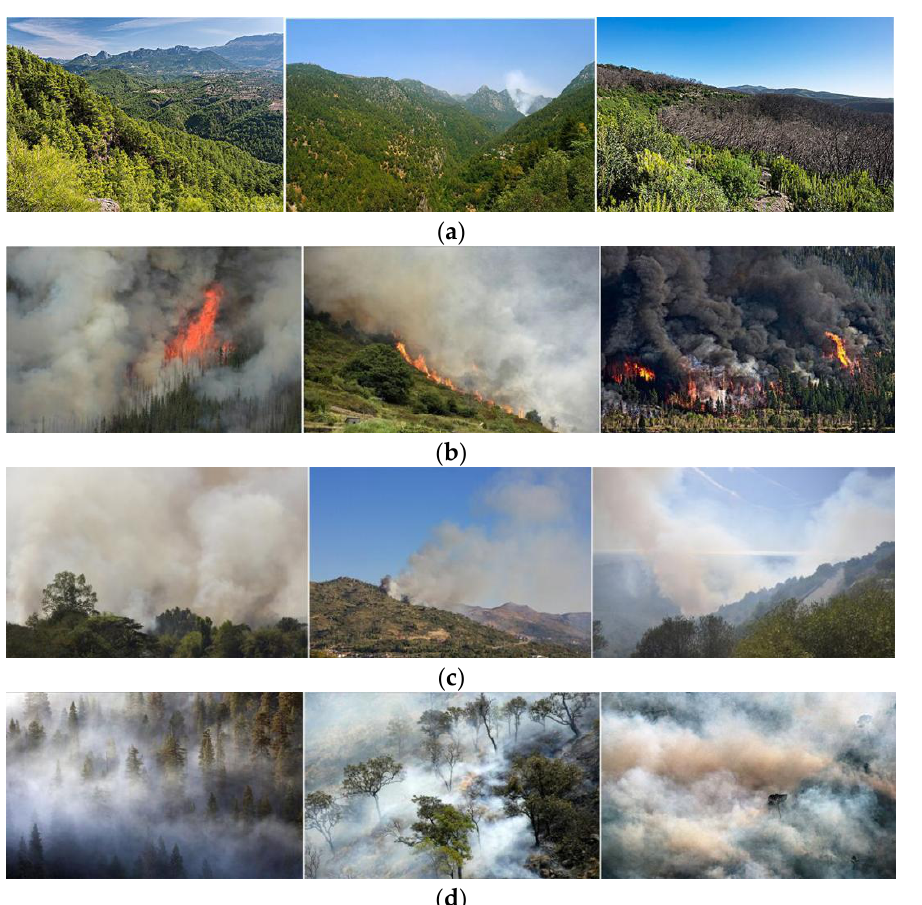
Figure 8. Fire risk image classification using the DCN_Fire model. ( a ) Images without fire character- istics; ( b ) images with flames; ( c ) images with smoke; and ( d ) misclassified images with mist.